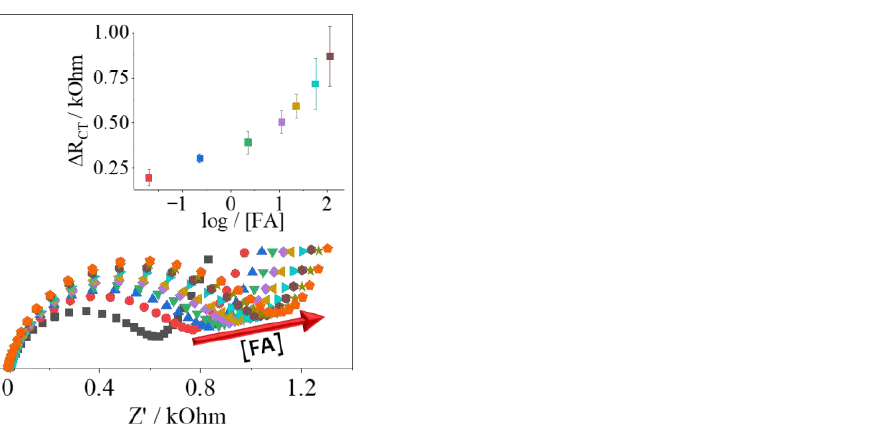
Figure 6. Folic Acid detection (0.02 up to 113.3 nmol L −1 ) using the PPy/AuNPs-modified electrode. Table 3. Comparison between experimental conditions and LOD values between different biosensors for FA detection.